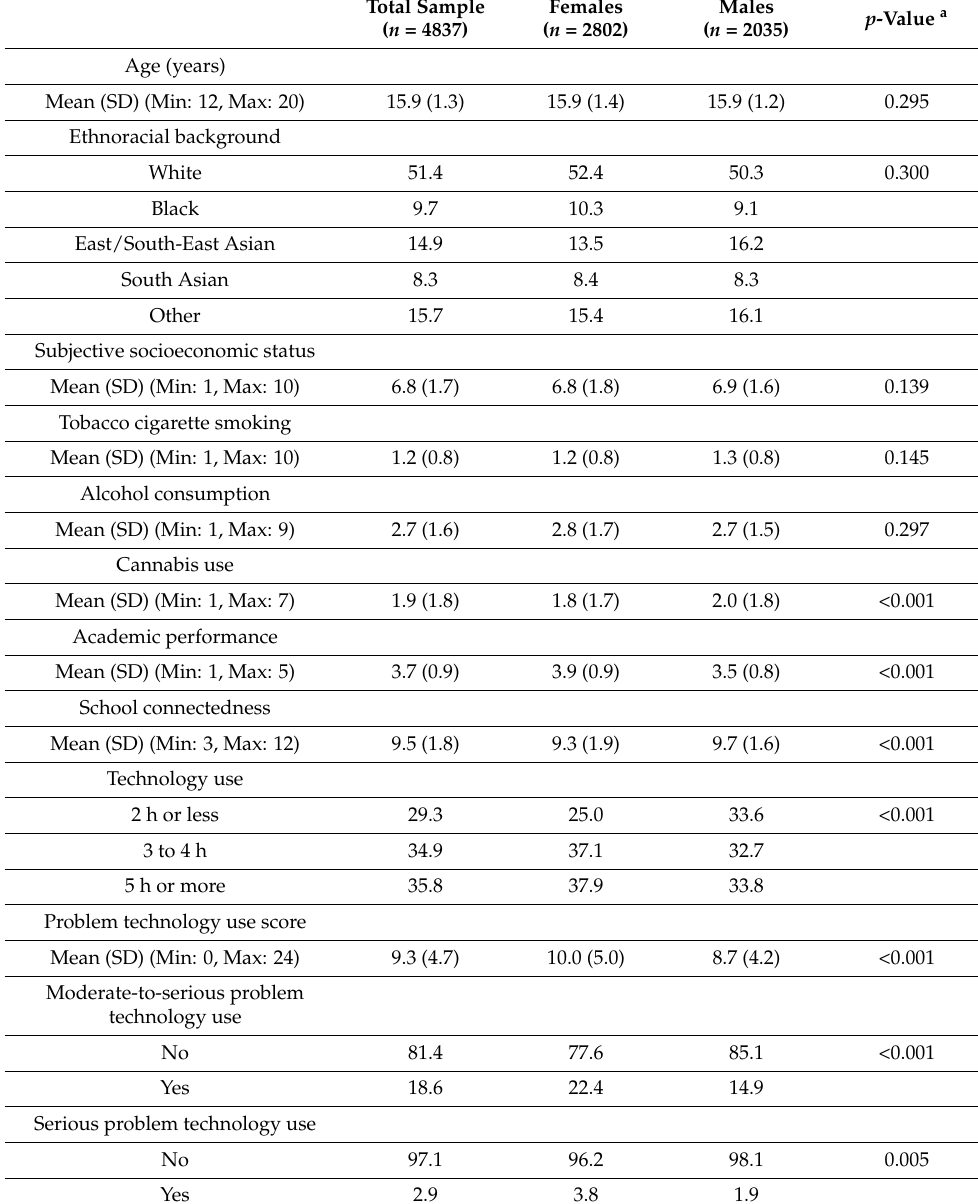
Table 1. Descriptive characteristics of the study